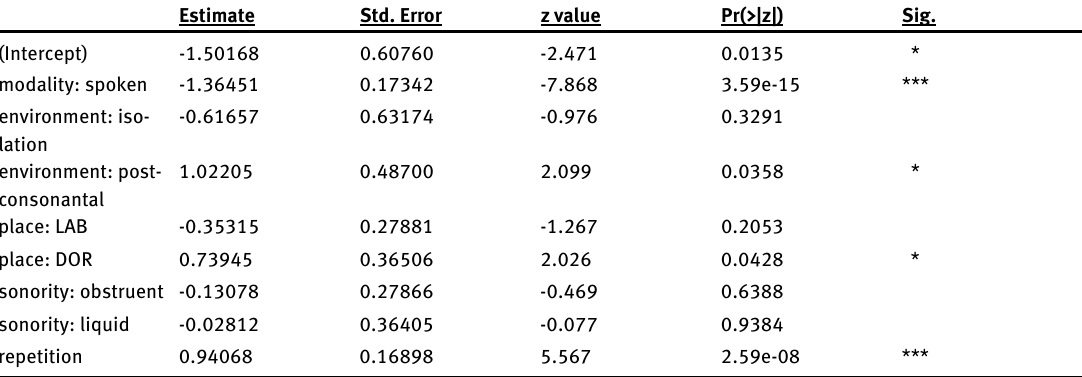
Table 5. Mixed-effects logistic